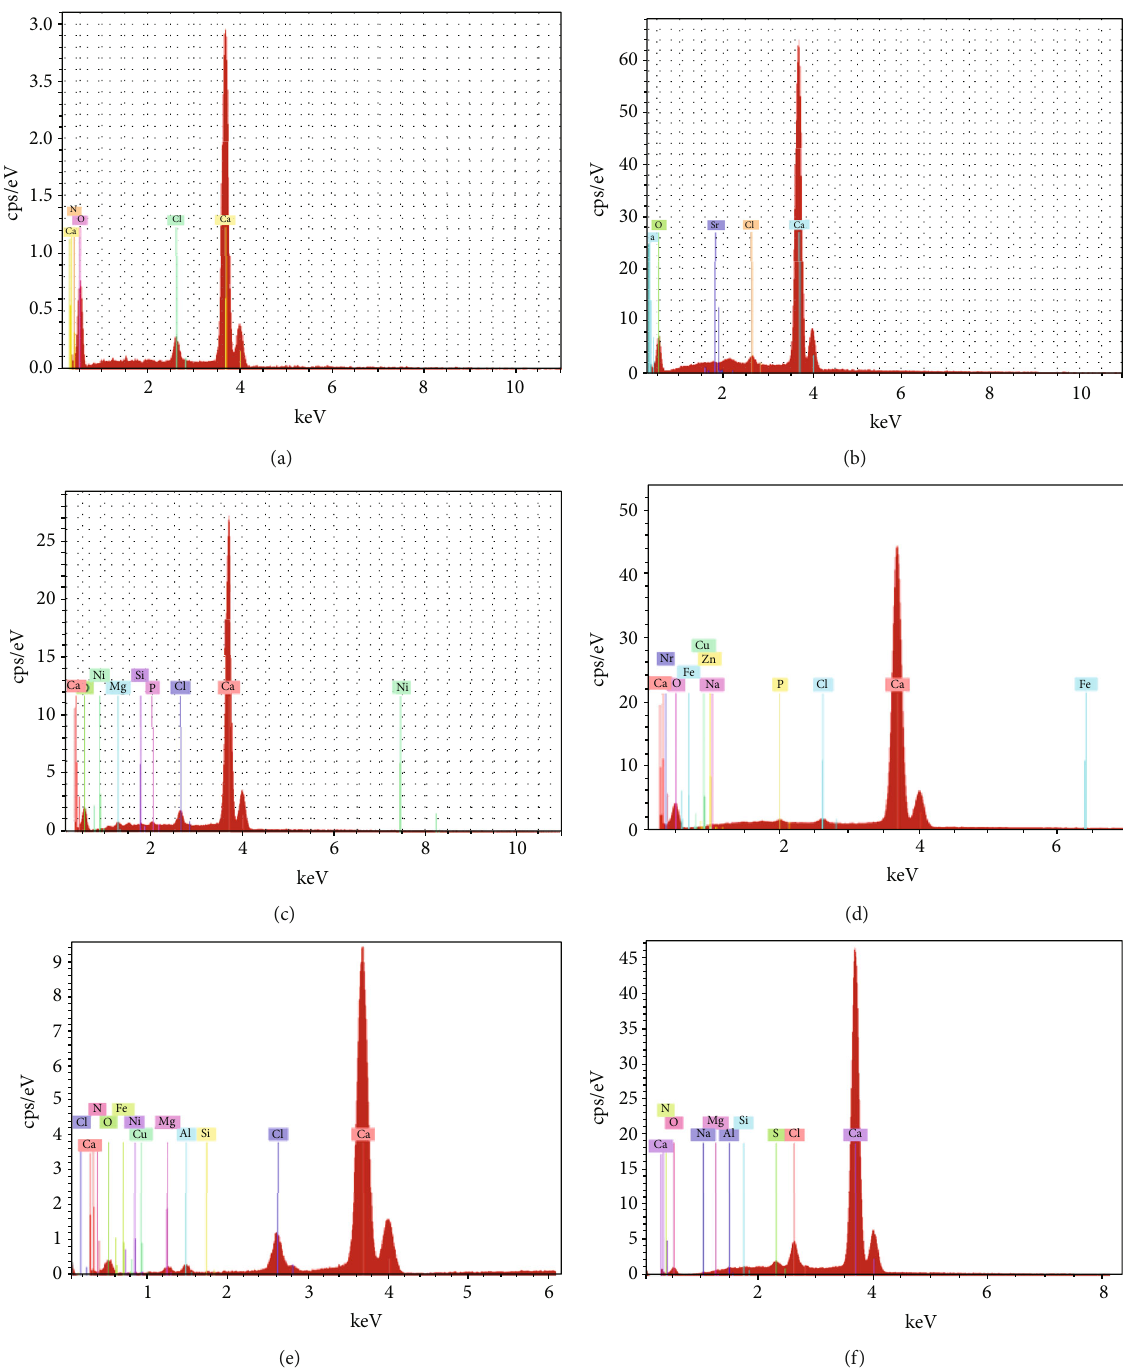
Figure 10: Energy spectrum analysis of cement. The energy spectrum analysis chart of the calcium carbonate cement deposited in each experimental group: (a) blank group; (b) BSA; (c) sucrose; (d) bamboo leaves; (e) bamboo leaves+MgCl